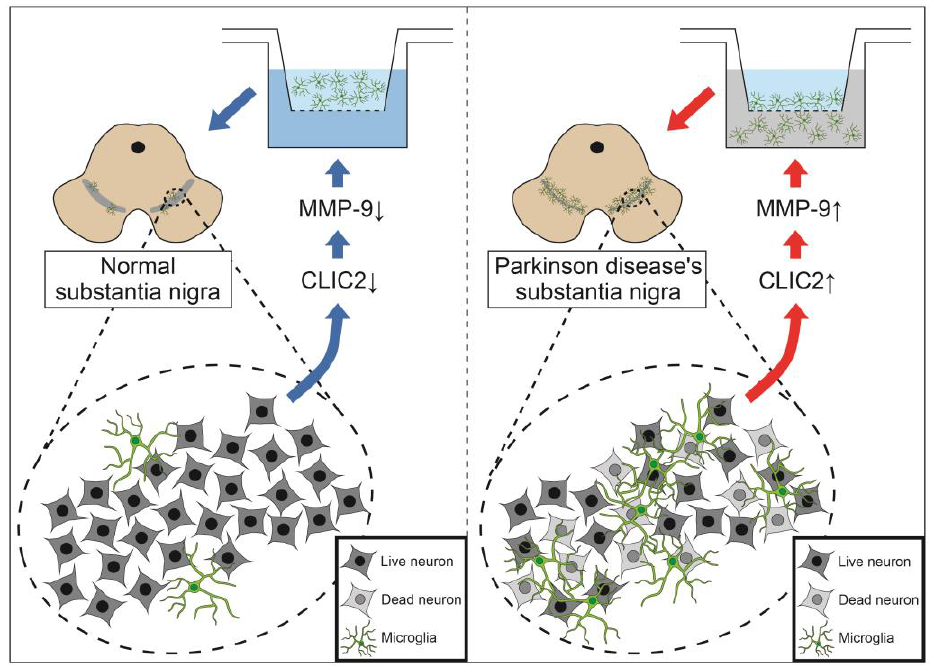
Figure 7. Diagram of the present hypothesis. Under normal condition ( Left ), CLIC2, MPP-9 expression, and microglial invasion in substantia nigra pars compacta are minimal. In PD condition ( Right ), increased CLIC2 expression results in increased MMP-9 activity and microglial invasion in the substantia nigra pars compacta.